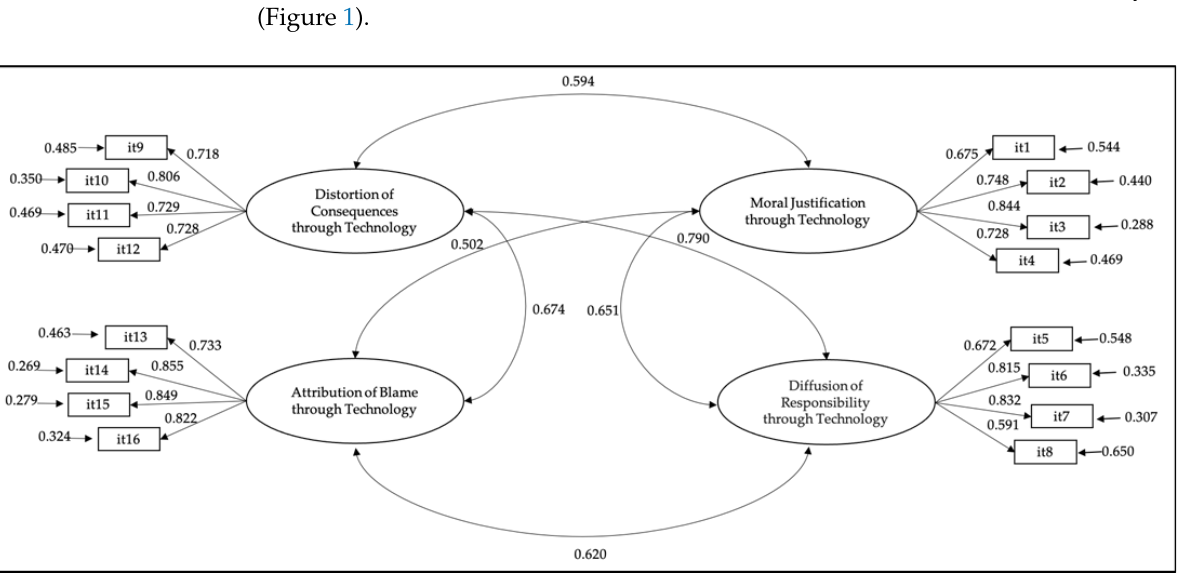
Figure 1. Four-factor correlated model. All the parameters were statistically significant ( p < 0.001).